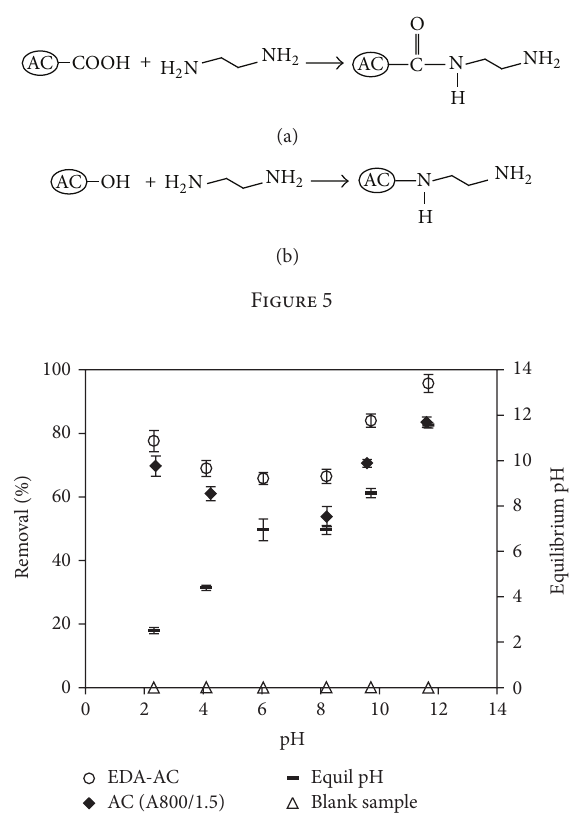
Figure 6: Effect of pH on equilibrium sorption of glutaraldehyde on EDA-AC. 𝐶 𝑜 : 200 mg/L; 298 K; 0.8 g/L AC; − 425 + 150 𝜇